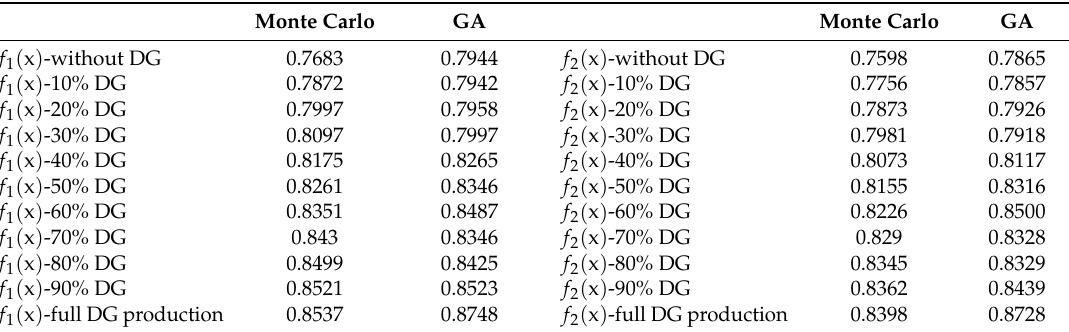
Table 7. Minimization results for f 1 ( x ) and f 2 .